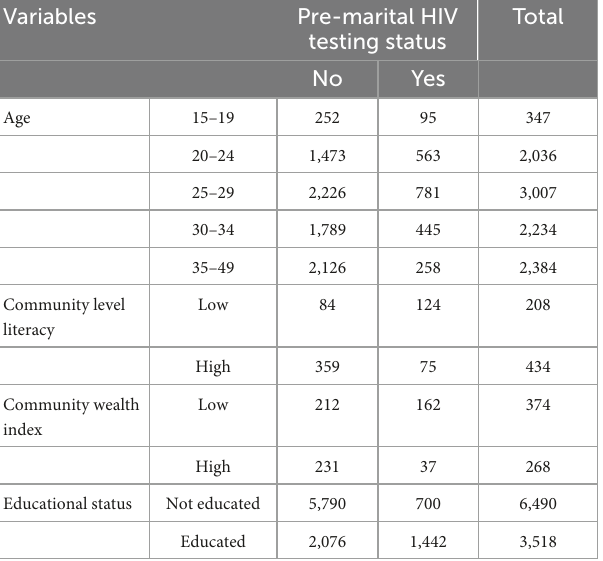
marriage. Furthermore, communities with high level of literacy are 0.62 (AOR = 0.38; 95 percent CI: 0.22, 0.66) times less likely to have HIV tested before marriage ( Table 5 ).